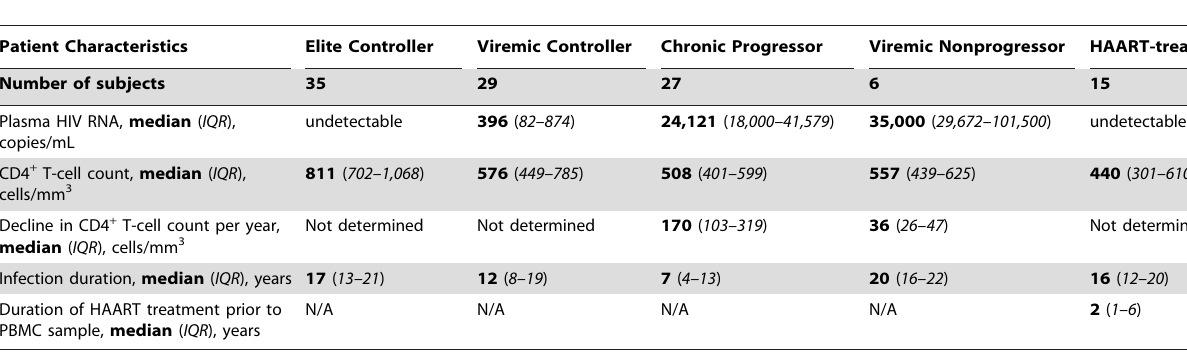
Table 1. Clinical parameters of HIV infected subject